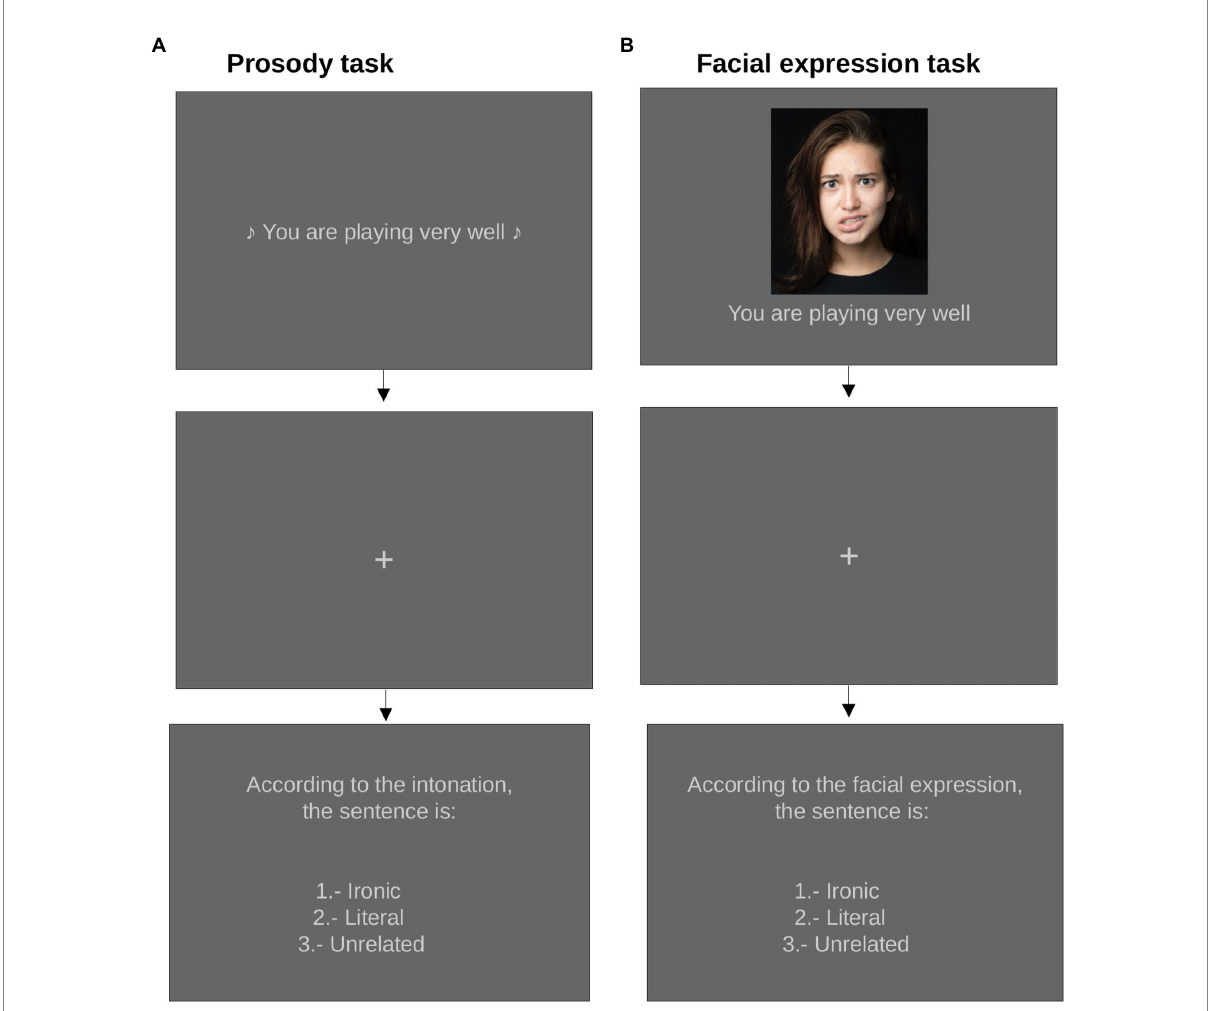
FIGURE 7 Prosody and facial expression tasks (Panel A,B , respectively). For both tasks stimuli were split into two versions, counterbalancing female and male voices or faces. The first slide presented the statement, then a fixation cross was shown for 1 s, followed by a slide that asked the participant to classify the statement heard or read. The photograph presented in panel (A) is an illustrative image (photo by Ospan Ali, available from Unsplash; https://unsplash.com). For the experiment, we used the images from Du et al. (2014) with permission from the